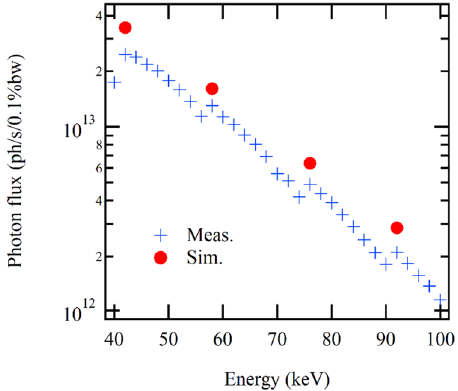
Fig. 8 Photon fl ux from the 1.5 m long CPMU at beamline ID15A. The fl ux was measured for a 18 mm period with 0.97 T peak fi eld at 6 mm gap, through a pair of slits set at 0.2 × 0.2 mm 2 at 30 m distance. The plus signs represent measurements after optimising the monochromator energy for each undulator gap value. The disks are calculations for an ideal undulator (undulator harmonics 5 – 11). The horizontal emittance of the storage ring was 160 pm